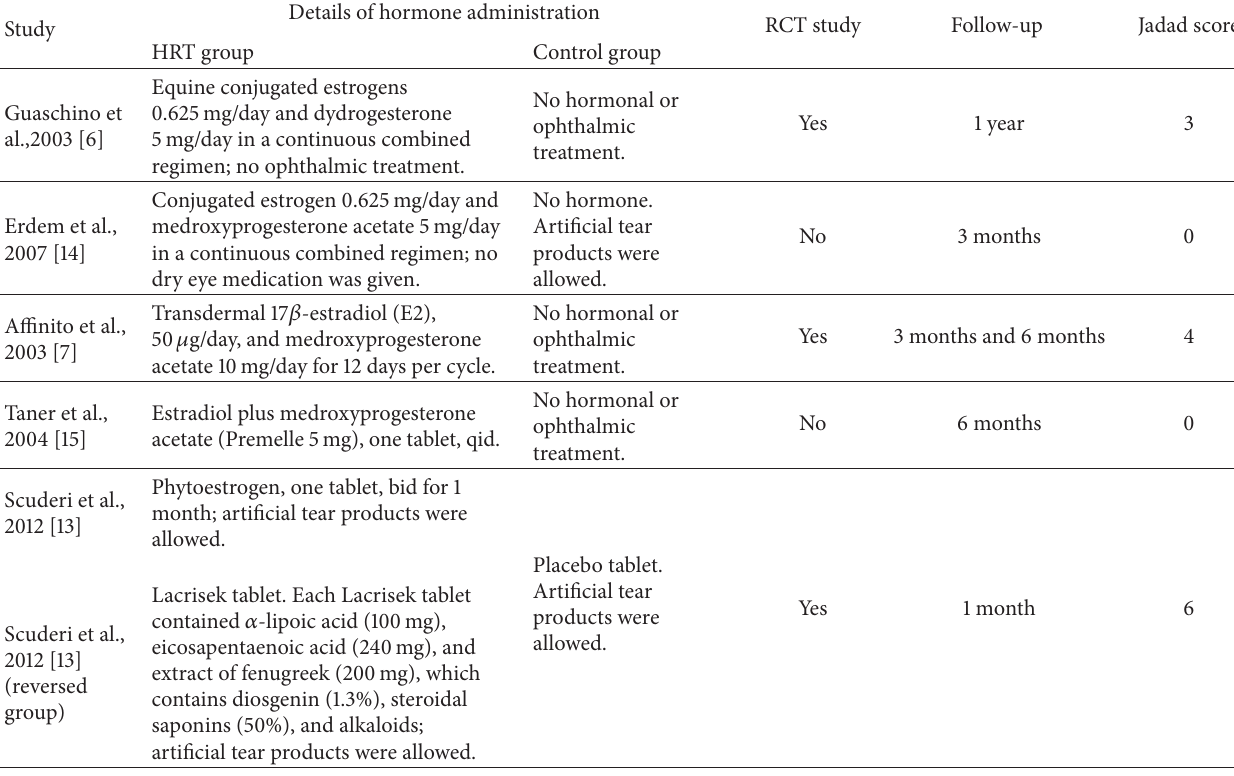
Table 1: Detailed protocols for the included studies.